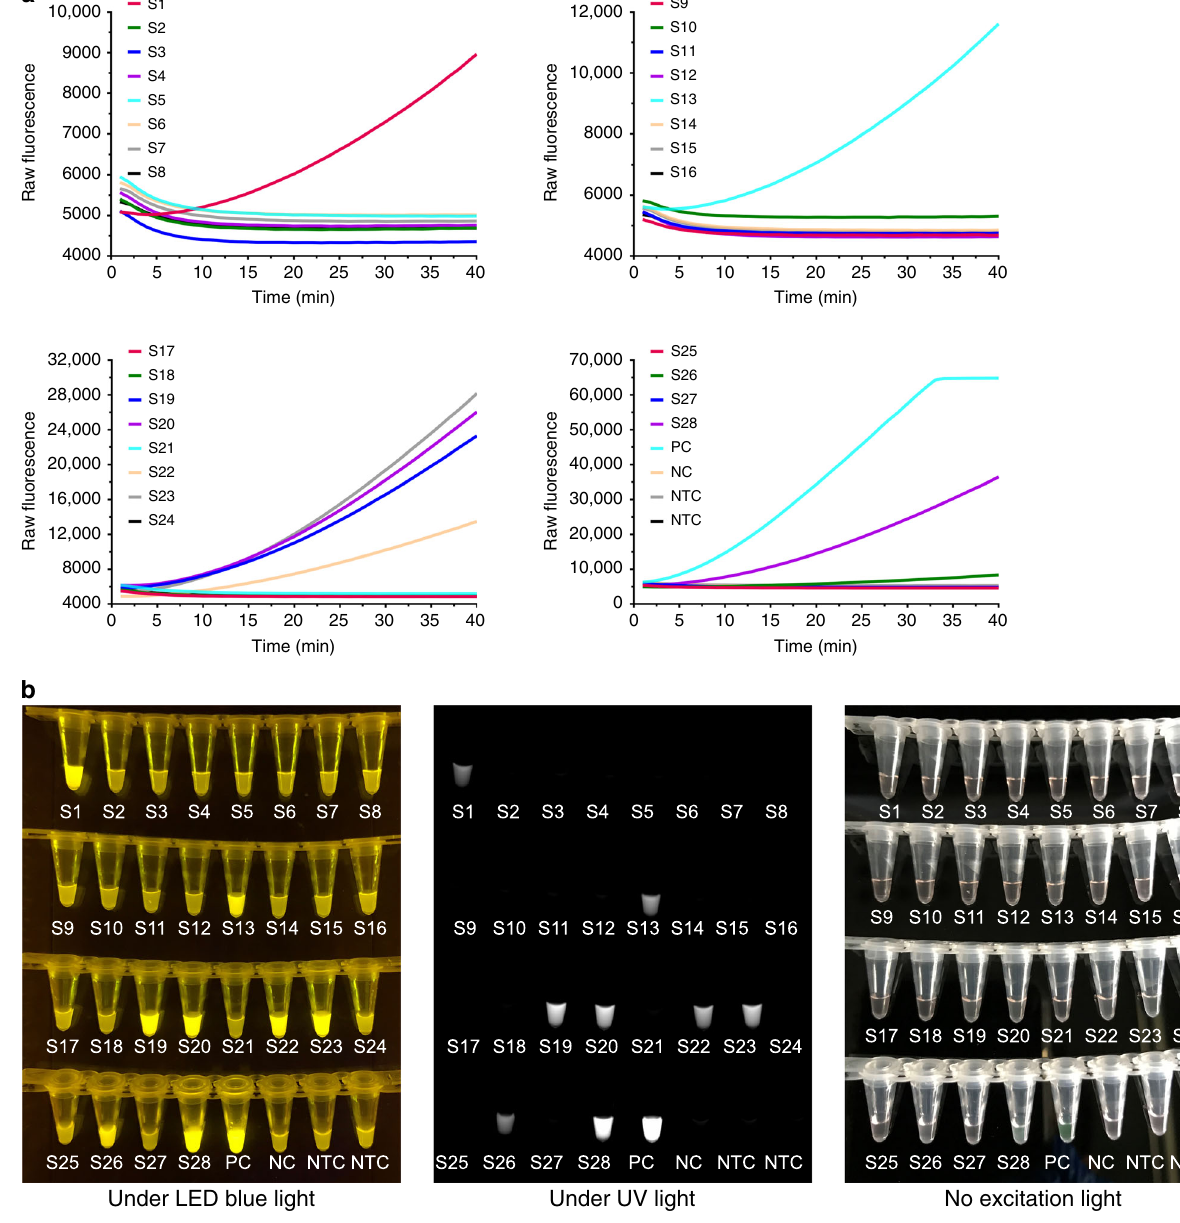
Fig. 4 Detection of SARS-CoV-2 in clinical swab samples by RT-AIOD-CRISPR assay. a Real-time RT-AIOD-CRISPR detection. b Endpoint fl uorescence/ visual detection after 40 min incubation. PC, positive controls with 4.6 × 10 4 copies of synthetic SARS-CoV-2 N RNA. S1-S28, clinical samples 1-28. NC, SARS-CoV-2-negative control reaction. NTC non-template control